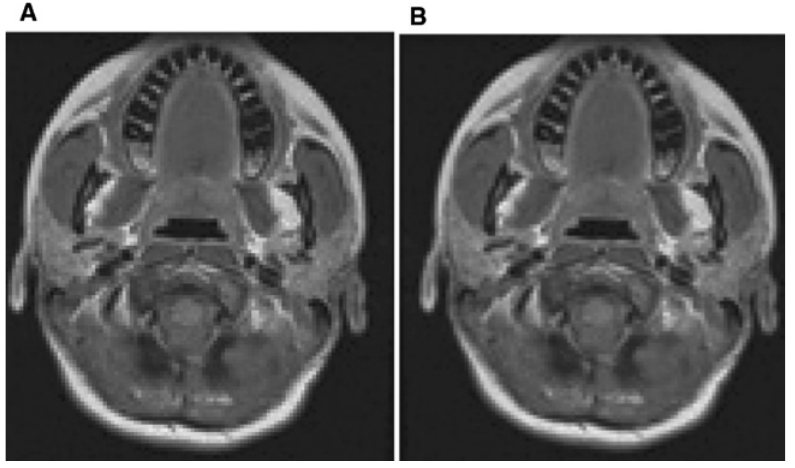
Figure 5: (A) Host Image and (B) Watermarked Image.